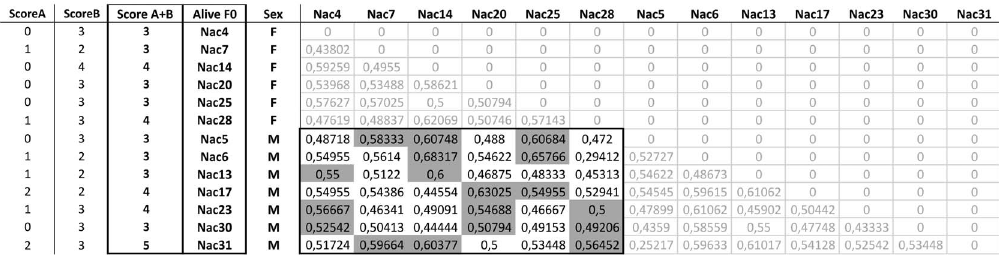
Figure 1. F0 breeding plan. Distance matrix at 24 microsatellite loci between the current F0 stock (Wild-Present) individuals. The already-existing families generated by each F0 parent and represented by at least 10 animals were counted (ScoreA). ScoreB represents the number of crosses per F0 that should be planned in order to get at least three families per breeder in the F1 generation (ScoreA + B). Only crosses between males and females are selected. Cells highlighted in grey indicate crosses selected for the short-term breeding plan on the basis of ScoreA and ScoreB.